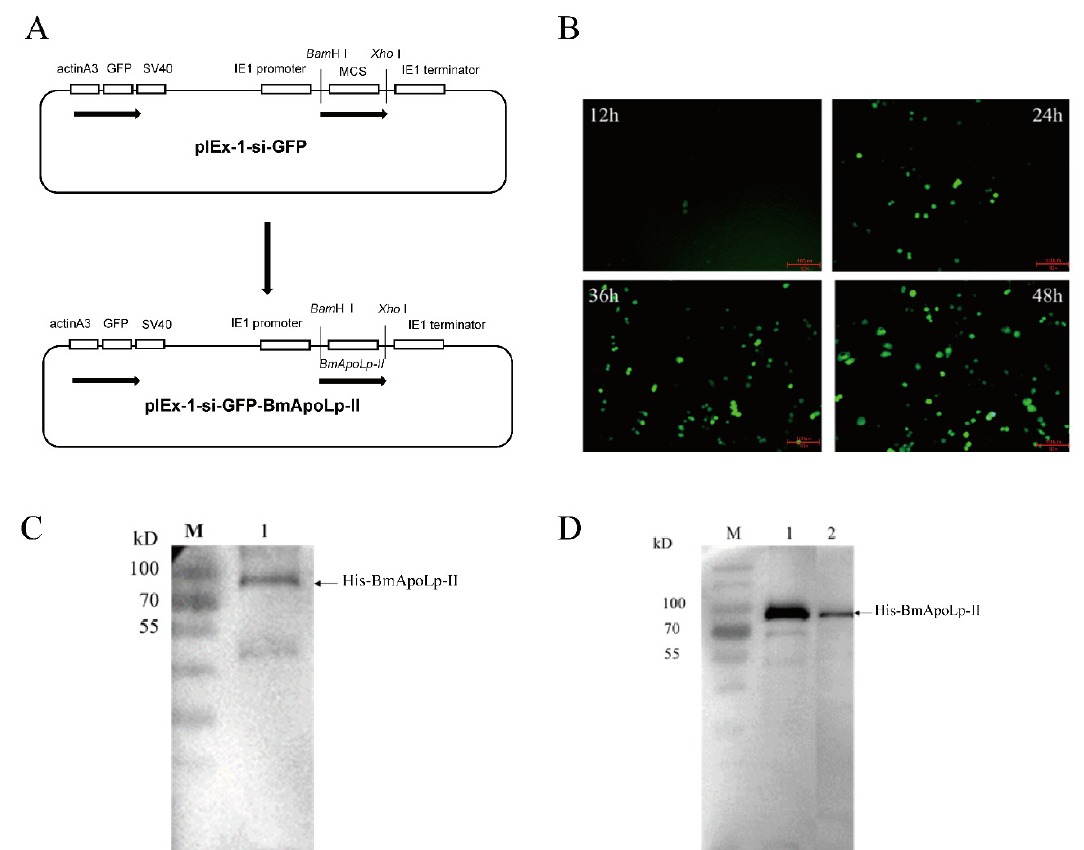
Figure 1. Identification of acetylation in BmApoLp-II protein. ( A ) The flowchart of pIEX-1-si-GFP-BmApoLp-II plasmid construction. ( B ) Expression of GFP co-expressed with BmApoLp-II in BmN cells. It was observed under a fluorescence microscope at different times after transfection. ( C ) Expression of BmApoLp-II fusion protein in BmN cells. It was identified by Western blotting using anti-His monoclonal antibody. ( D ) The immunoprecipitated BmApoLp-II protein was detected by Western blo tt ing using a pan-lysine acetylation antibody. M: Pre-stained protein marker; 1: Detec- tion by anti-His antibody; 2: Detection by pan-lysine acetylation antibody.